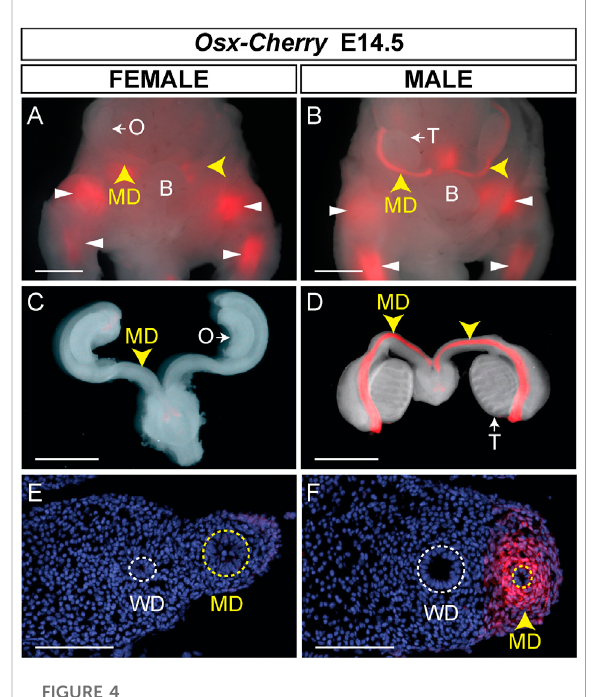
FIGURE 4 Male-speci fi c Müllerian duct mesenchyme expression in Osx-Cherry transgenic mice. (A – D) E14.5 reproductive tract organs from Osx-Cherry tg/0 mouse embryos visualized for Cherry fl uorescence. (A and B) Ventral views of whole mount bright fi eldand fl uorescentimagesmergedfor female (A) and male (B) embryos. Yellow arrowheads, Müllerian ducts (MD); white arrowheads, skeletal tissues. O, ovary; T, testis. (C and D) Bright fi eld and fl uorescent images merged of isolated reproductive tracts at E14.5. (C) Female, (D) male. (E and F) Cross sections through Müllerian ducts, visualized for Cherry fl uorescence and counterstained with DAPI. (E) Female, (F) male. WD, Wolf fi an ducts. Scale bars (A – D) = 1000 um; (E and F) = 100 um. Osx-Cherry tg/0 female embryos, n = 4; male embryos, n = 6.